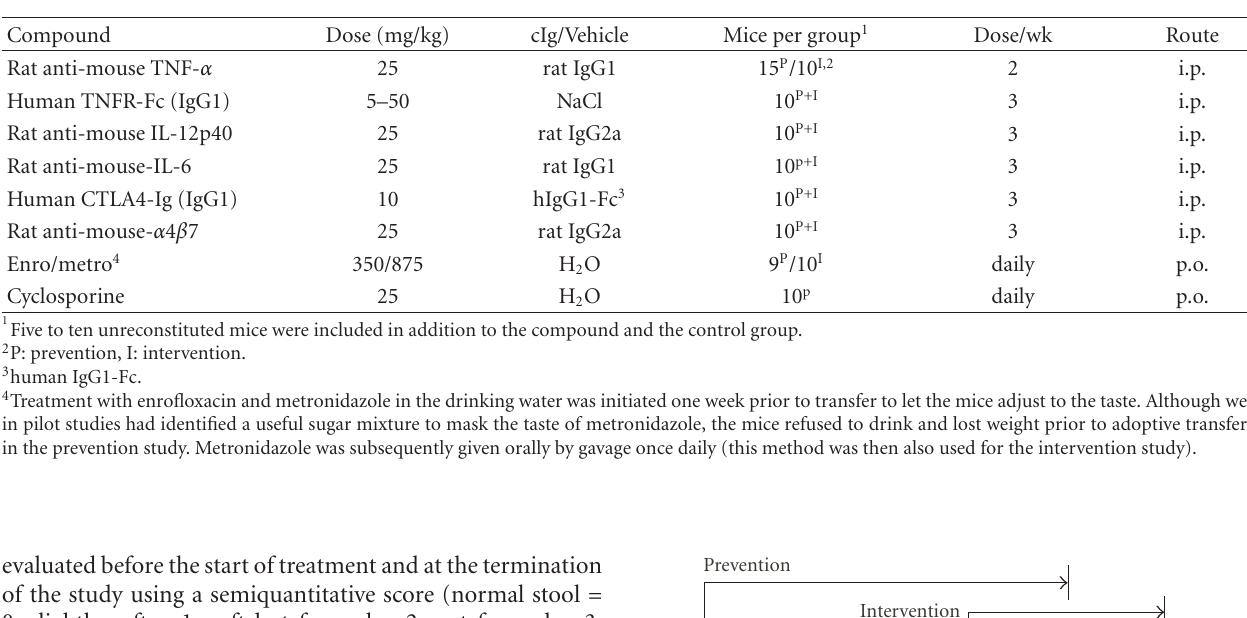
Table 1: Study design—administration of compounds.